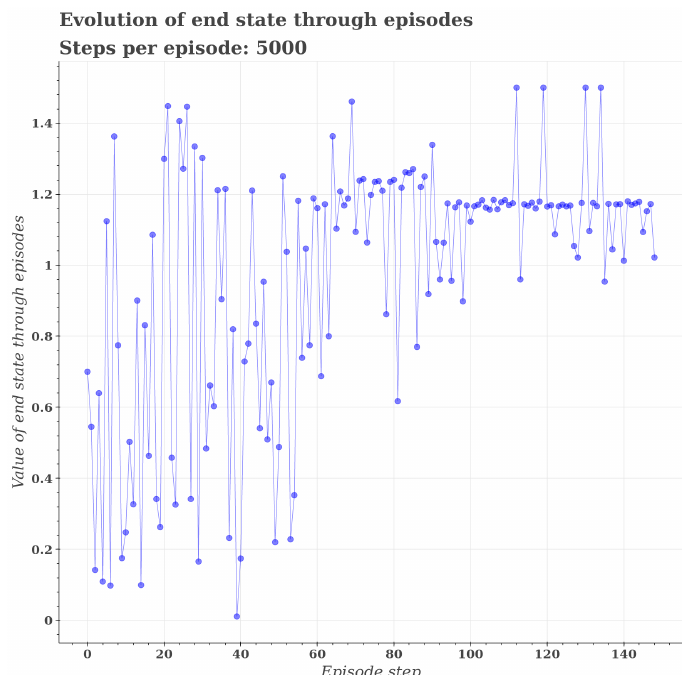
Figure 11. State of the agent at the end of each of the 150 episodes for the conjunctive function. After the exploration phase, around episode 70 the agent reaches a value near 1.2, which is similar to the solution provided by the evolutionary